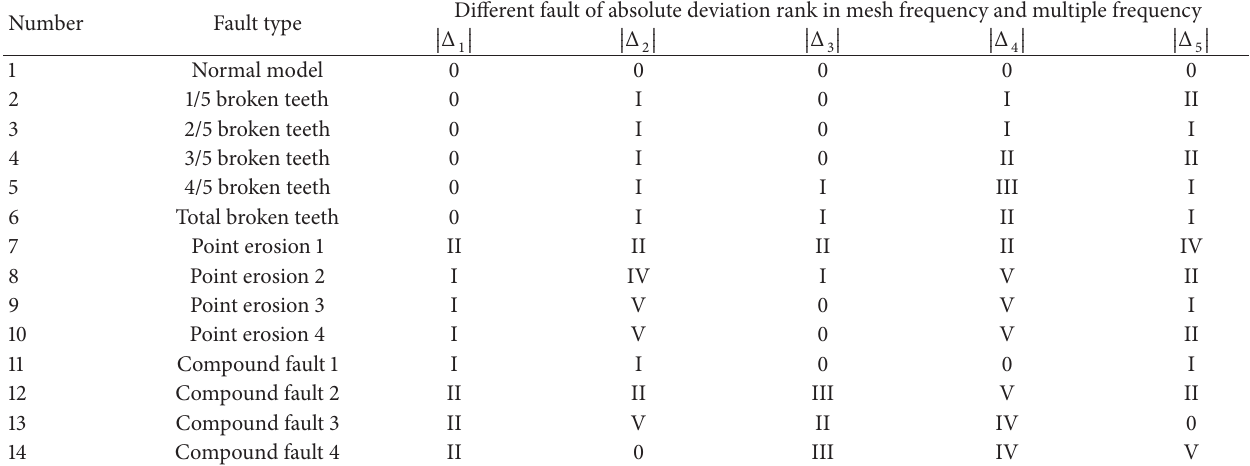
Table 4: The absolute deviation rank of different fault types vibration frequency amplitude.